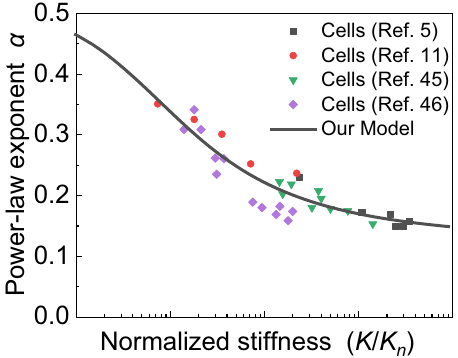
Fig. 6 The relation between power-law exponent and normalized cellular stiffness. The power-law exponent α versus cellular stiffness of different cell types and states in experiments 5,11,45,46 collapse onto a master curve. The stiffness of the cell corresponds to the inverse of the creep compliance J ð t Þ measured at t = 1 s or the storage modulus G 0 ð ω Þ measured at an angular frequency ω ¼ 1Hz.